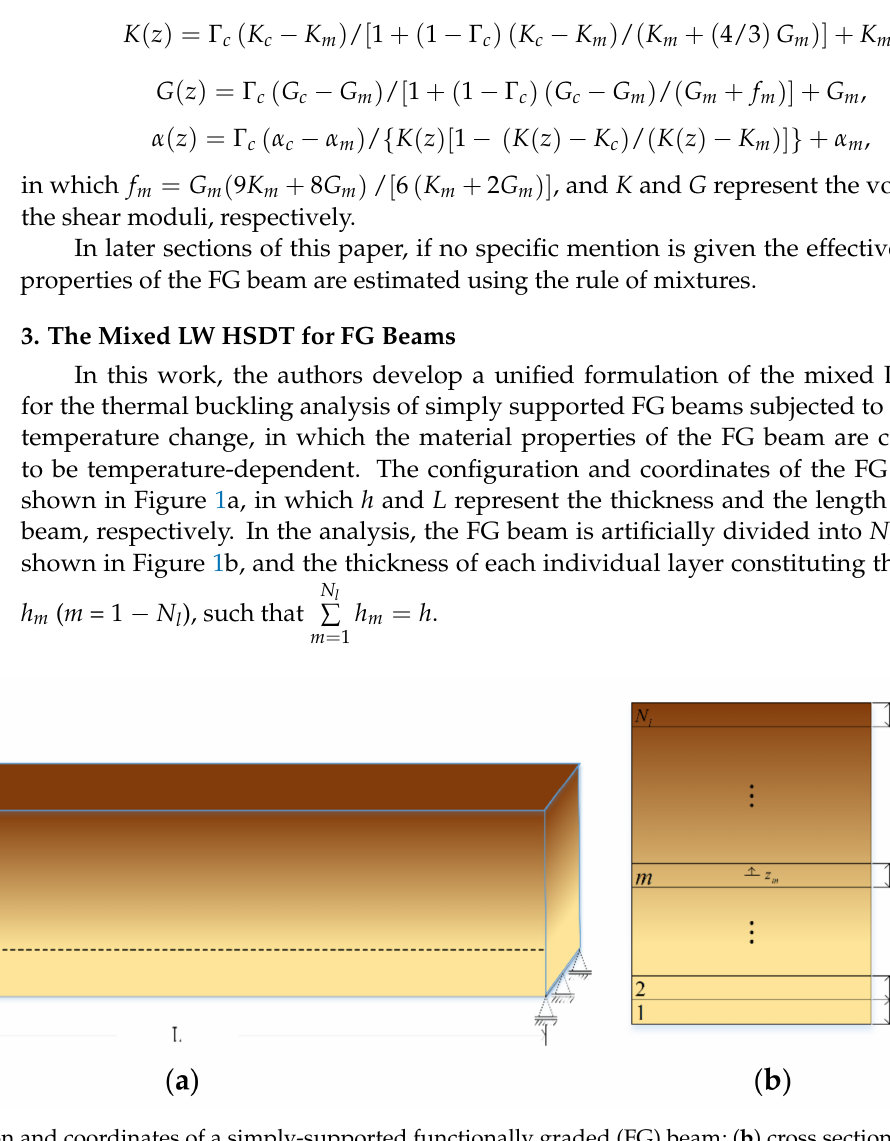
Figure 1. ( a ) Configuration and coordinates of a simply-supported functionally graded (FG) beam; ( b ) cross section of an N l -layered FG